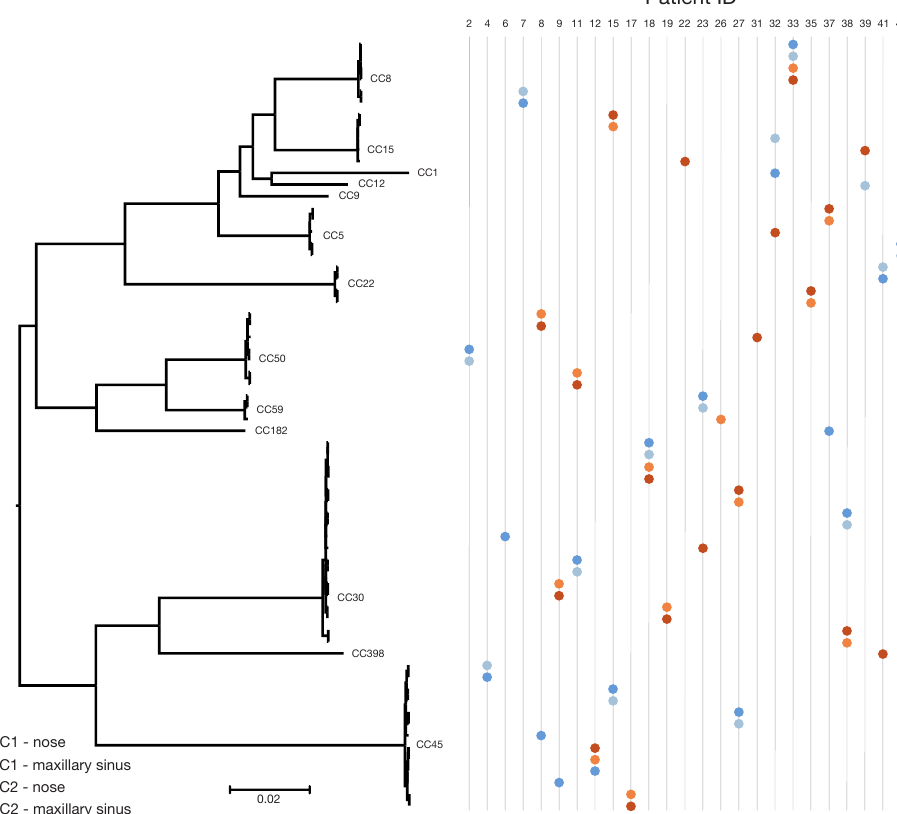
Figure 2. Midpoint rooted phylogenetic tree based on core genome single-nucleotide polymorphisms (SNPs) at initial collection (C1) and follow-up after 8–15 years (C2; mean follow-up: 11 years) in S. aureus isolated from CRS patients. Clonal complexes are presented. Based on 110,026 SNPs in the ~2.21 Mbp conserved core genome of the reference chromosome. Scale bar indicates substitutions per site. Nasal sample collected at C1 for patient number 39 was